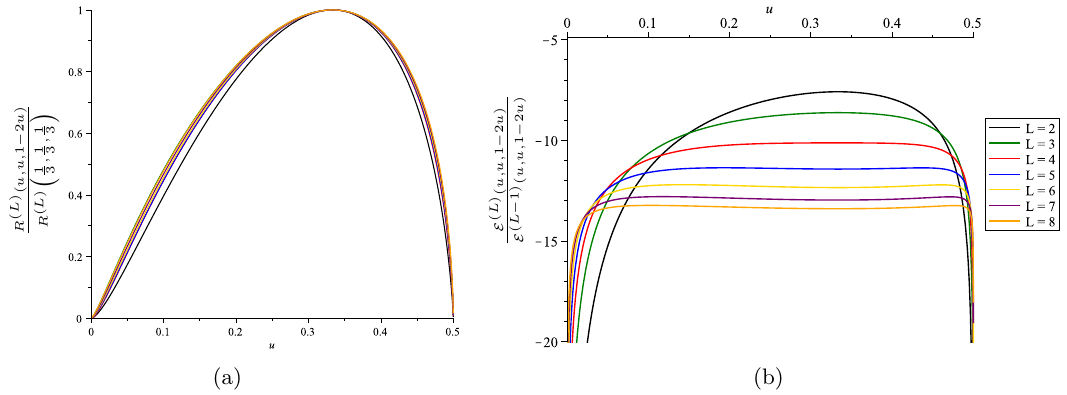
Figure 3. (a) The remainder function R ( L ) along the u = v line within the Euclidean region, which corresponds to 0 < u < 1 / 2 . We have normalized R ( L ) at each loop order by the maximum value it takes along this segment, which occurs when u = v = w = 1 / 3 . (b) The ratio of E at successive loop orders along the u = v line, within the Euclidean region.